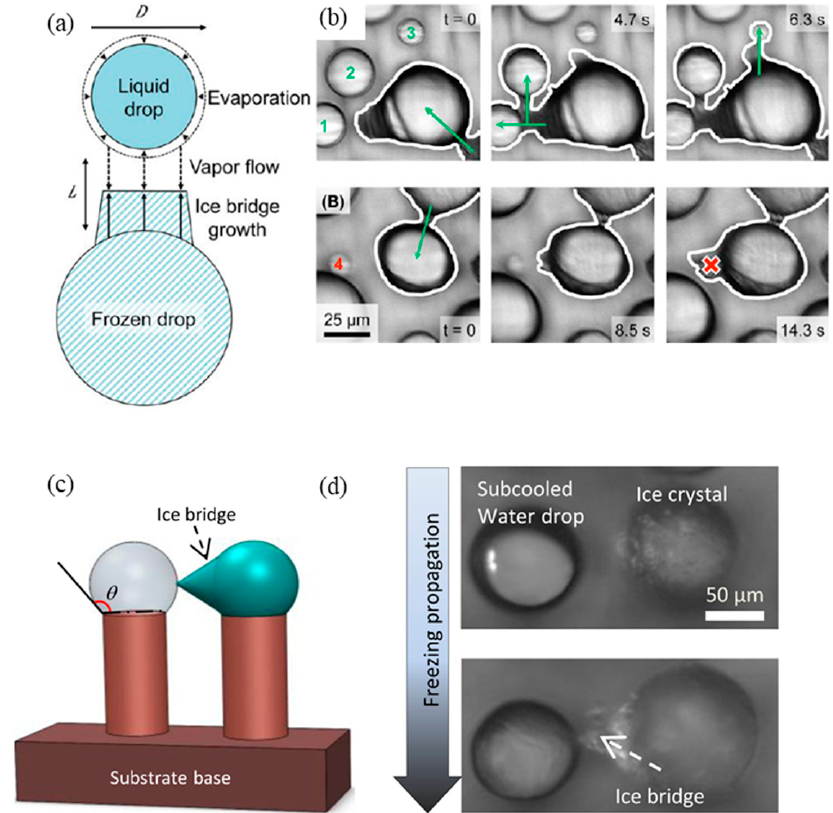
Figure 3. Ice bridging dynamics on smooth and topologically patterned surfaces. ( a ) Schematics